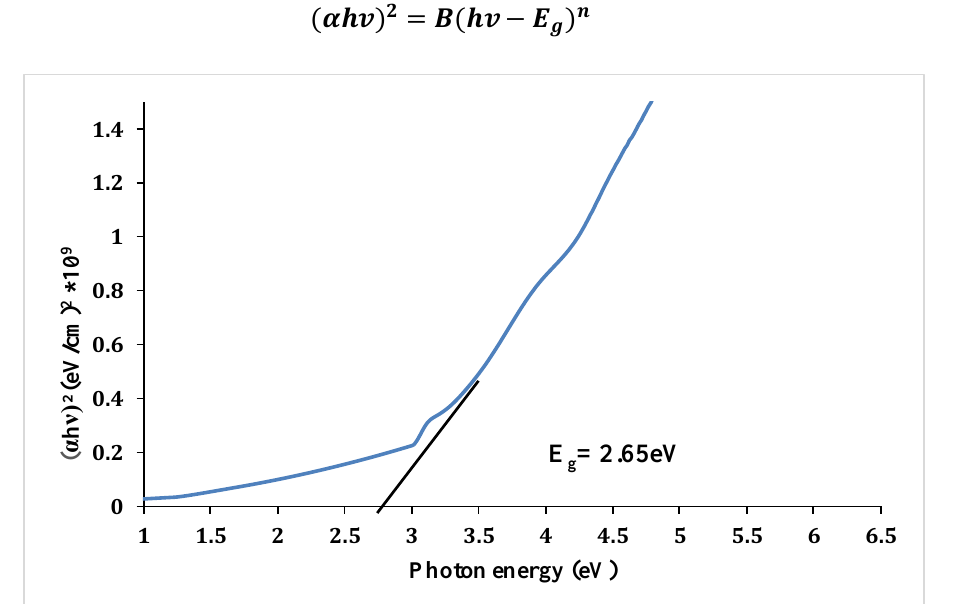
Figure 9: (α hυ) 2 vs. (hυ) plot for PbI 2